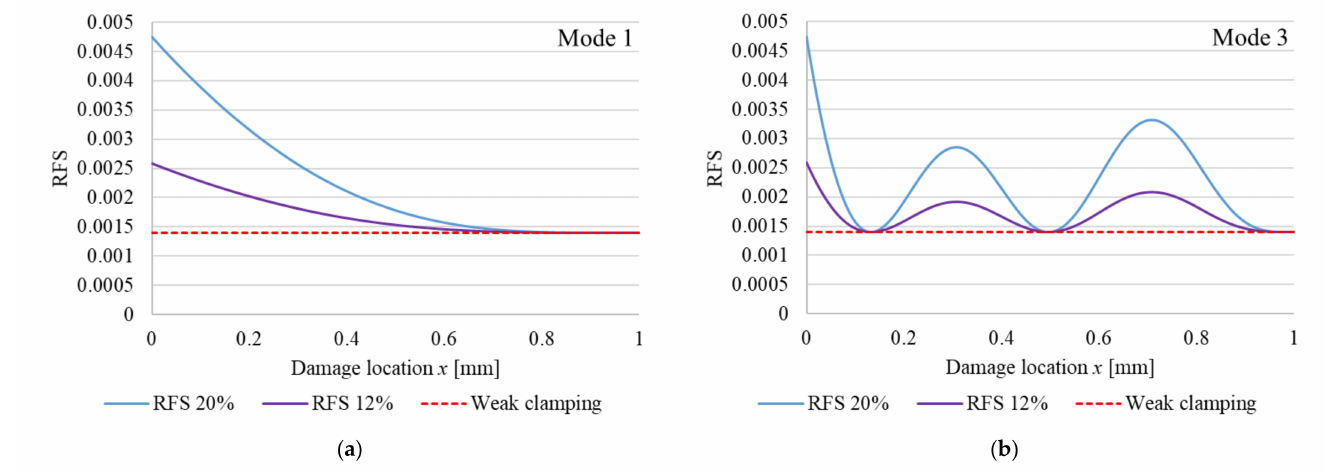
Figure 2. Plotted RFS functions for out-of-plain bending vibrations for a cantilever beam with non- ideal fixing: ( a ) vibration mode 1; ( b ) vibration mode 3. The functions are plotted for a cross-section reduction of 12%, respective